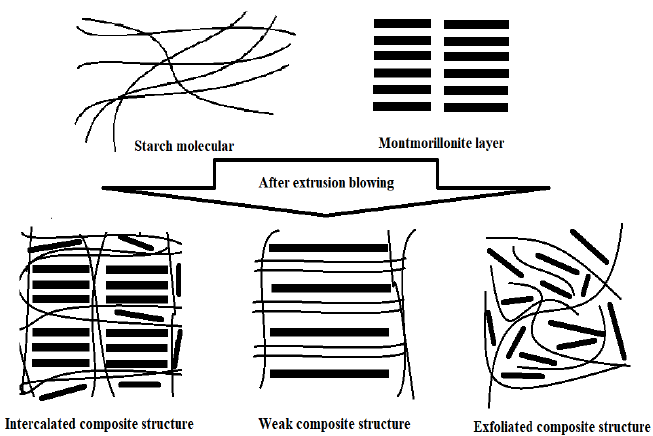
Figure 9. Schematic of composite structure of HPDSP with montmorillonite (MMT)